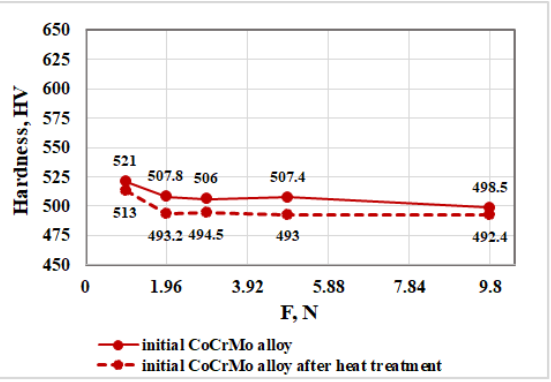
Figure 6. Influence of load on the hardness of the initial CoCrMo alloy before and after heat treatment.